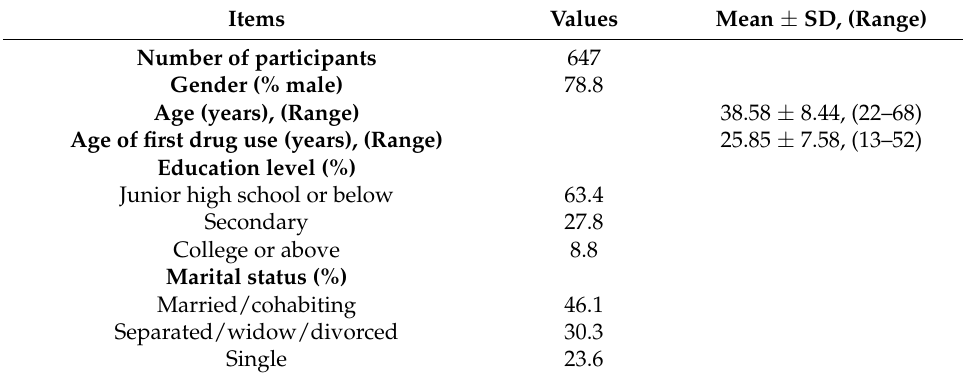
Table 1. Demographic characteristic of the participants (n =